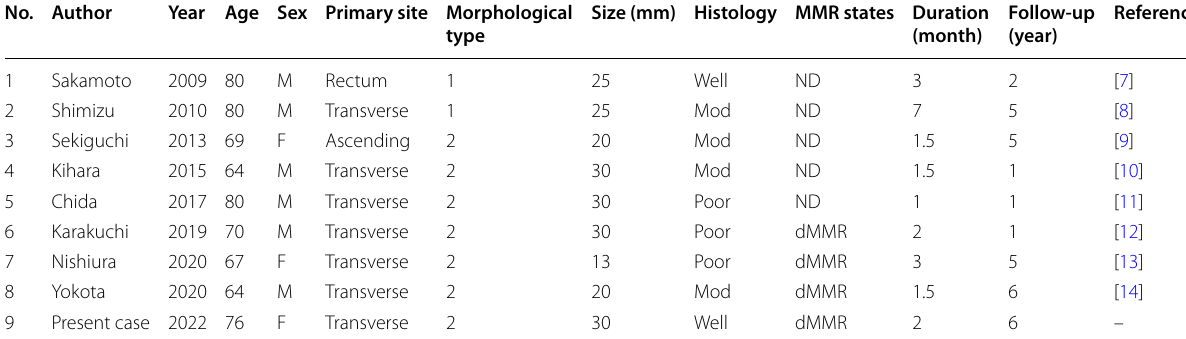
Well well-differentiated adenocarcinoma; Mod moderately differentiated adenocarcinoma; Poor poorly differentiated adenocarcinoma; dMMR deficient mismatch repair; ND not described